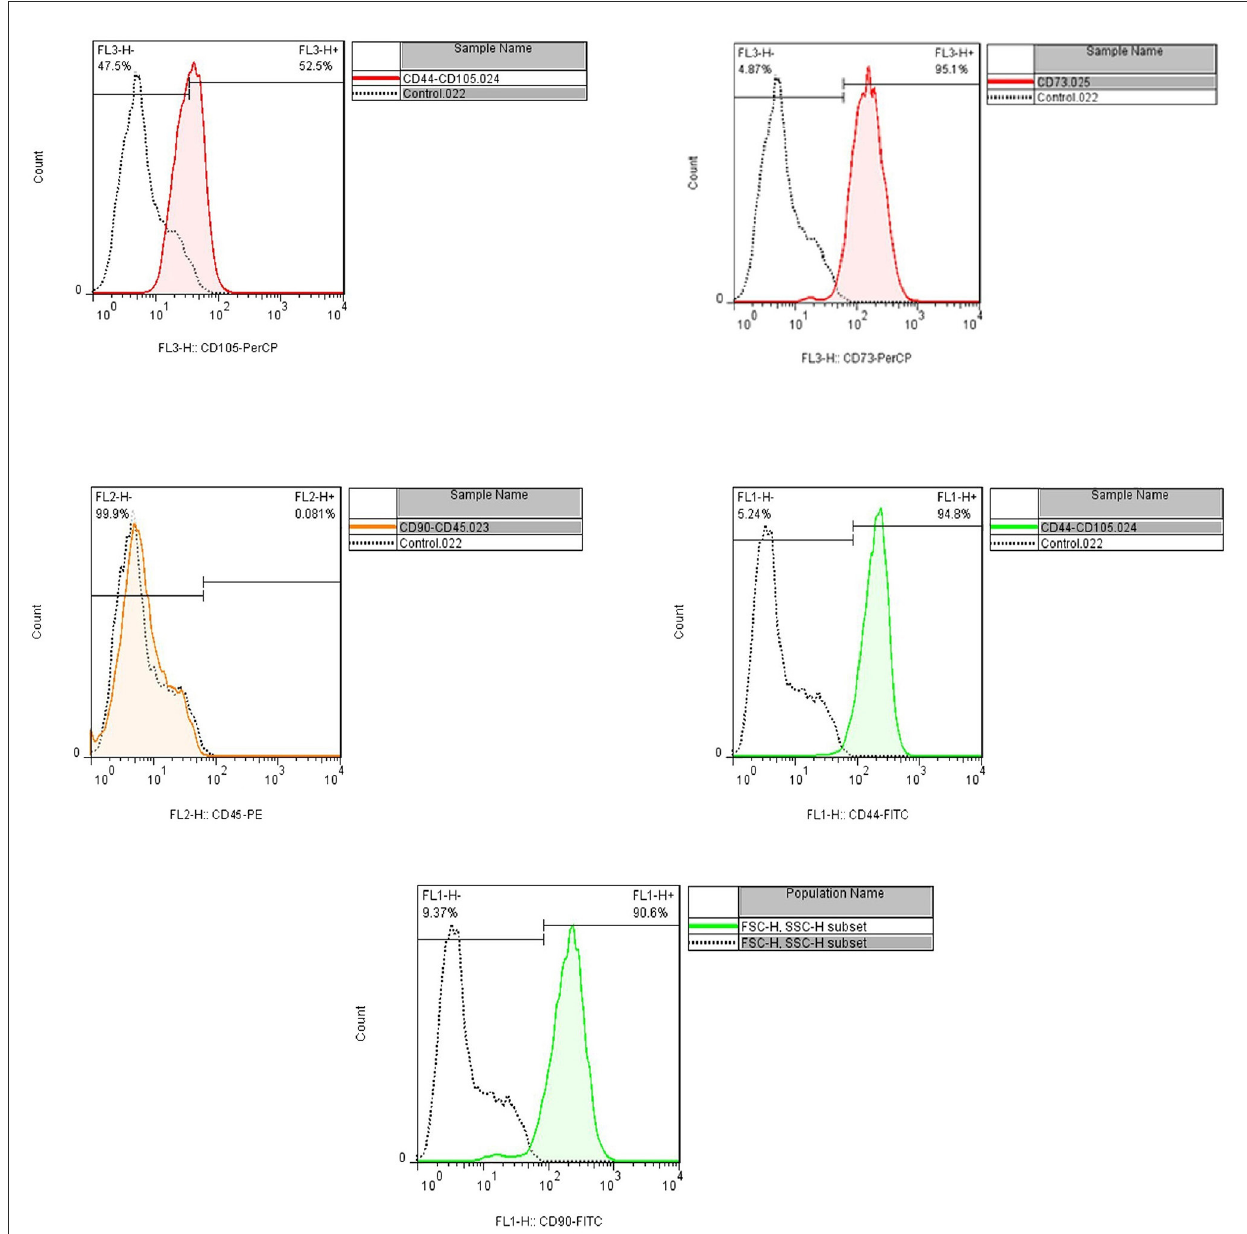
FIGURE4 Flow cytometry assay indicated the positive expression of CD44, CD90, CD73, and CD105 (94.8, 90.6, 95.1, and 52.5%, respectively), and CD45 were not expressed ( <